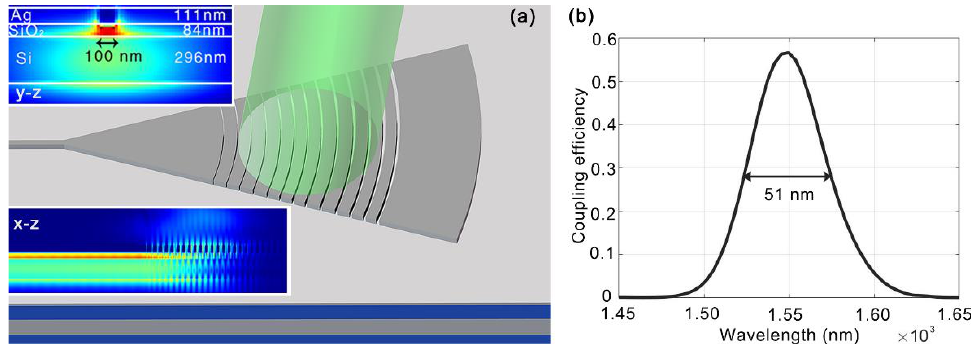
Figure 7. ( a ) 3D schematic of the silicon HPW-fiber coupler. Here, the HPW has no Si or SiO 2 etched but only a metal cap. The upper and lower insets show the mode profile of the TM 0 mode of a 100 nm-wide HPW (y-z plane) and the light propagation (x-z plane), respectively. ( b ) Simulated transmission spectrum from the fiber to the 100 nm-wide HPW.